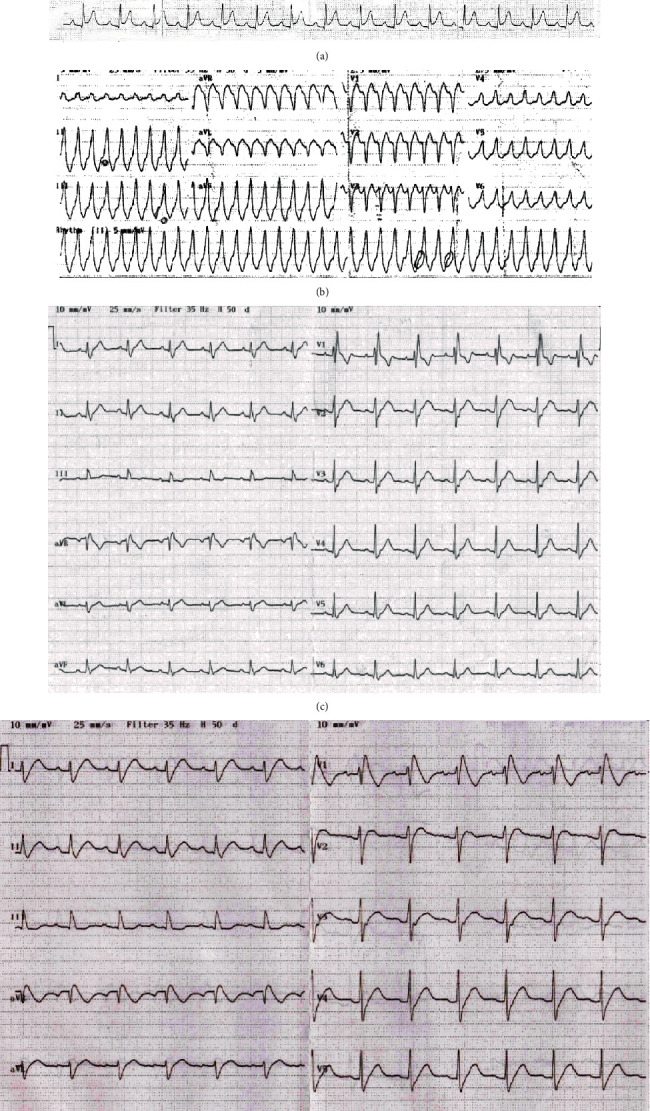
(a) ECG analysis of patient MMRL 1126 showing early repolarization phenotype. A prominent ST segment elevation and slurring of the QRS complex is apparent in several leads. (b) Infusion of dobutamine caused the appearance of monomorphic VT in MMRL1126 which persisted after dobutamine was discontinued. (c) The arrhythmogenic focus was ablated and patient subsequently exhibited RBBB apparent in lead V1. (d) Patient was challenged with ajmaline resulting in unmasking of BrS.